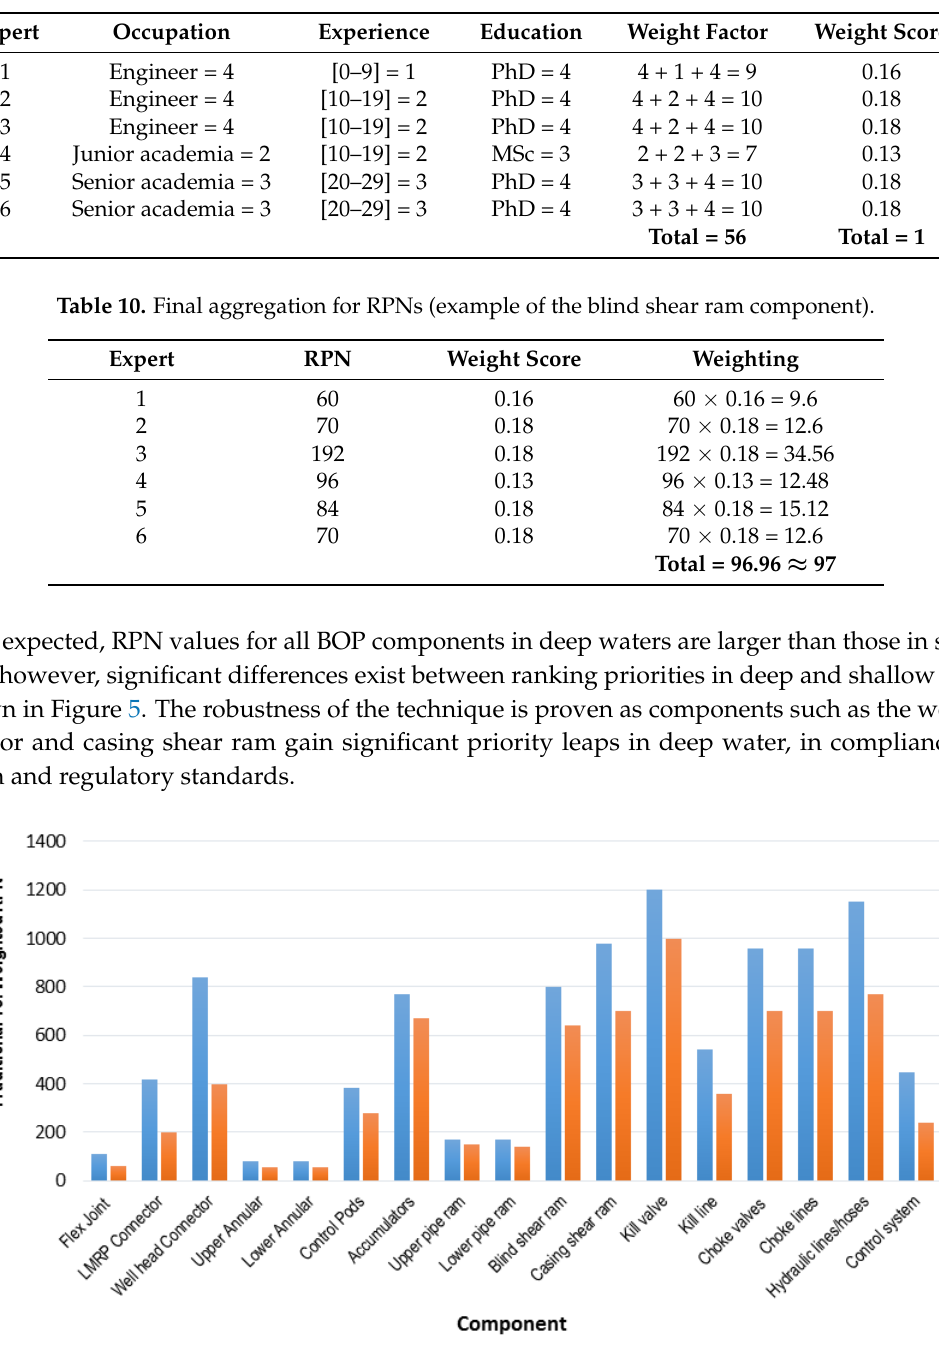
Table 9. Expert weighting.